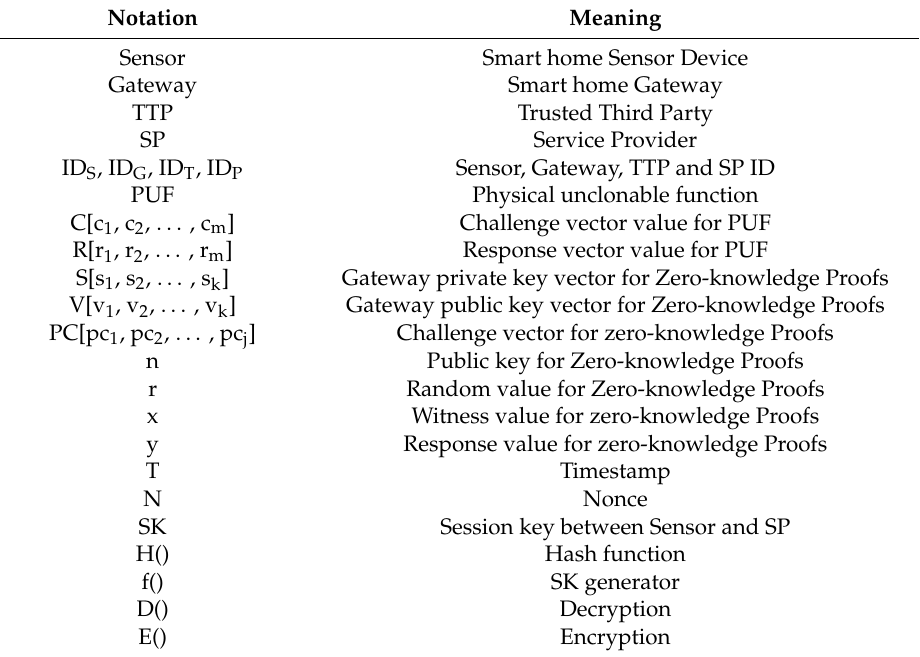
Table 1. Proposed Protocol